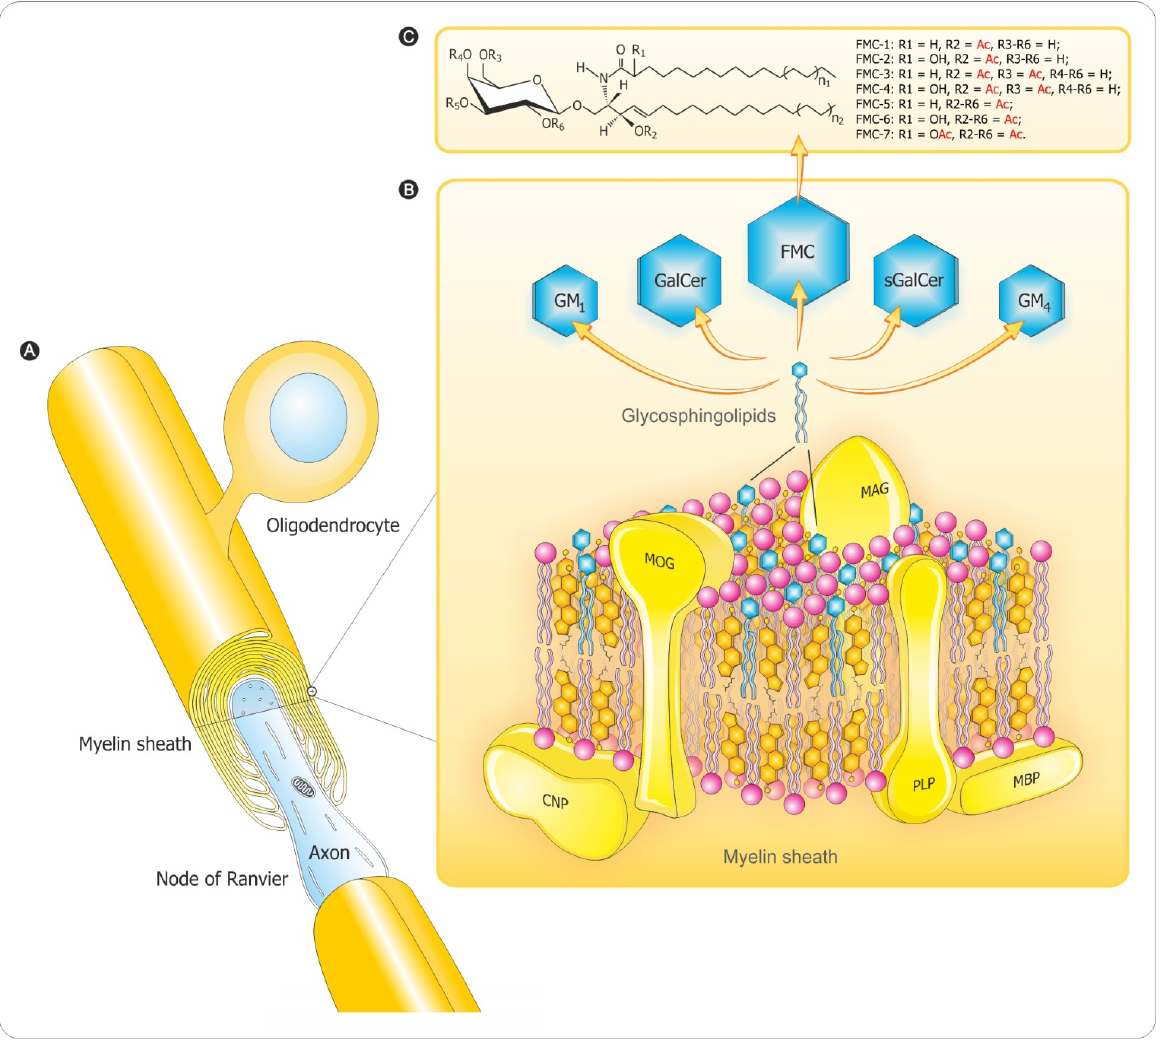
permission of Future Medicine Ltd. Additional abbreviations: CNP, myelin basic protein; MOG, myelin oligodendrocyte glycoprotein; PLP, proteolipid